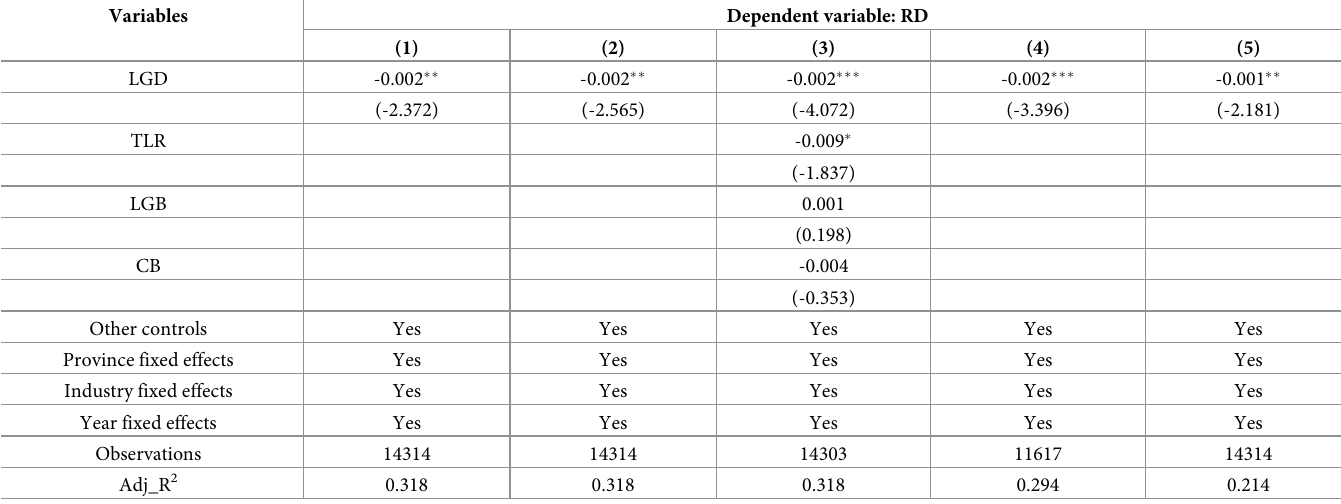
Table 10. Robust Test